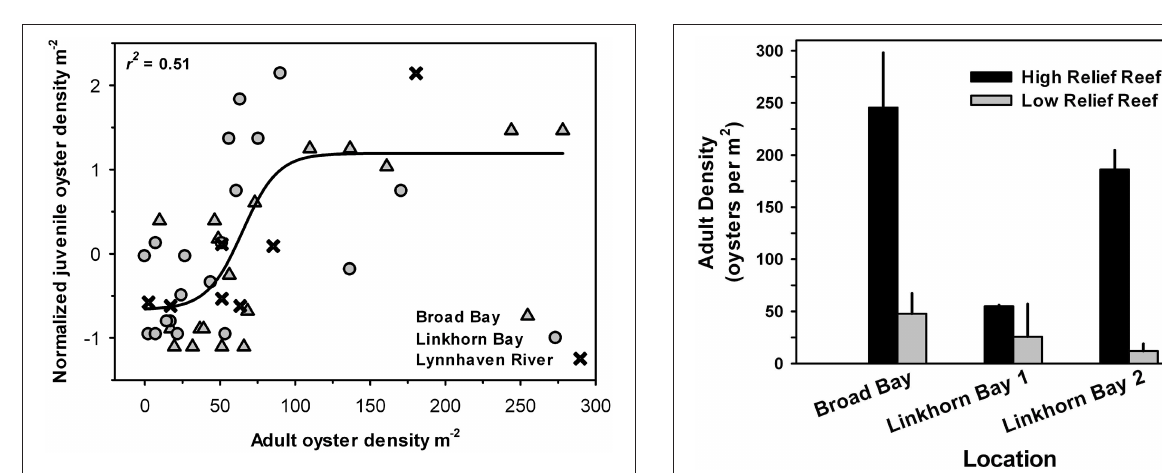
FIGURE 10 | Adult oyster density as a function of reef height for a subset of the data for which the measure of reef relief was reliable. Oyster density was higher on high-relief reef than on low-relief reef in all locations, and significantly so for all Broad Bay reefs and for Linkhorn Bay reef 2 (ANOVA, p < 0 . 05